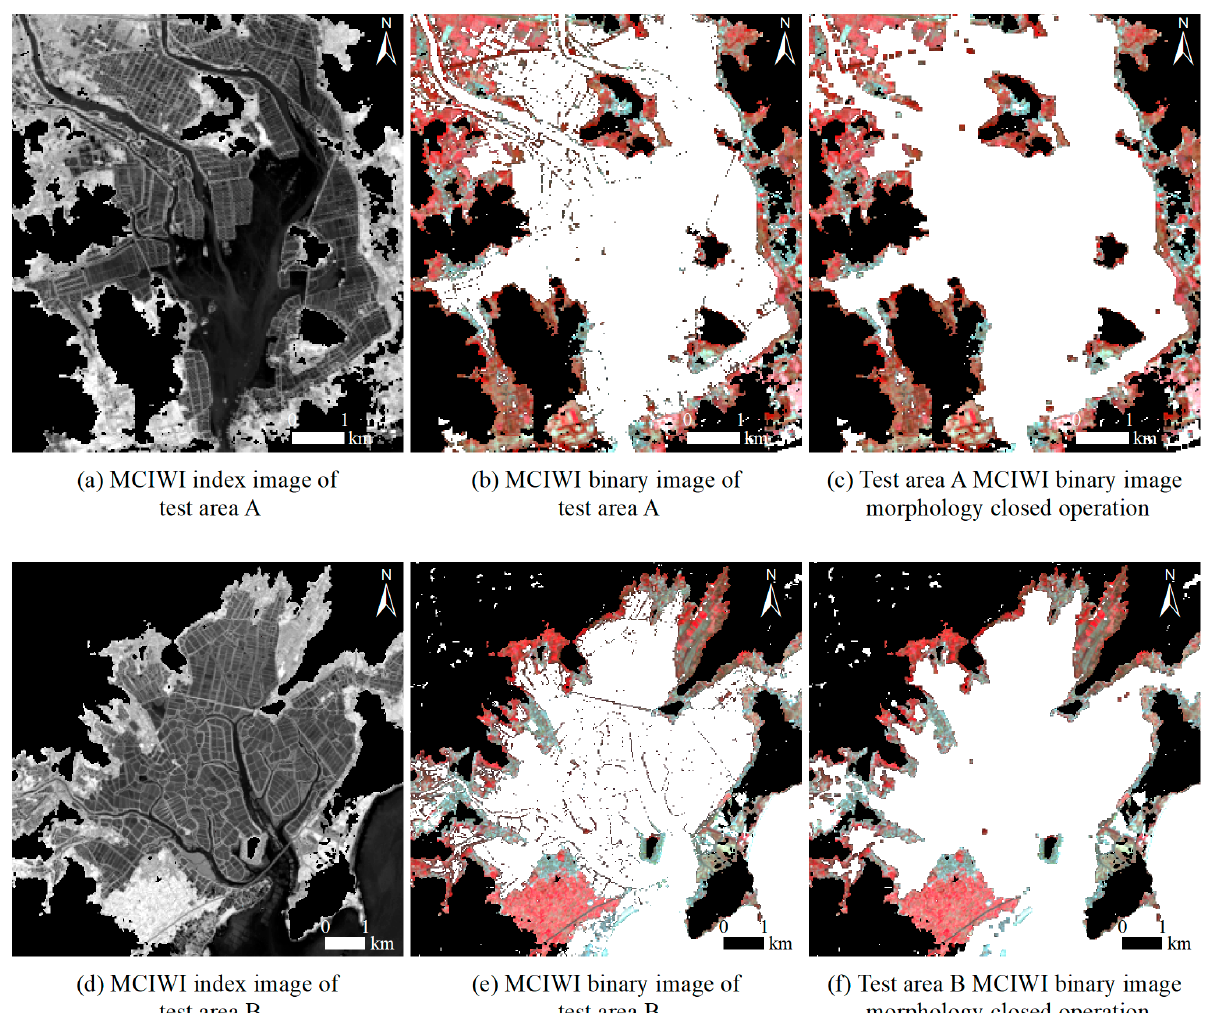
Figure 6. Elimination of non-water-body information in test area A (B).